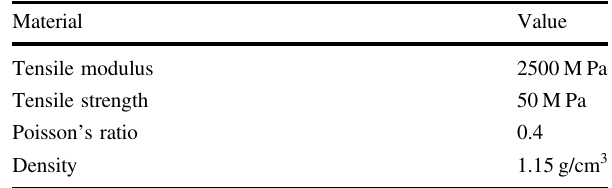
Table 1 Material properties of the Anycubic translucent UV resin